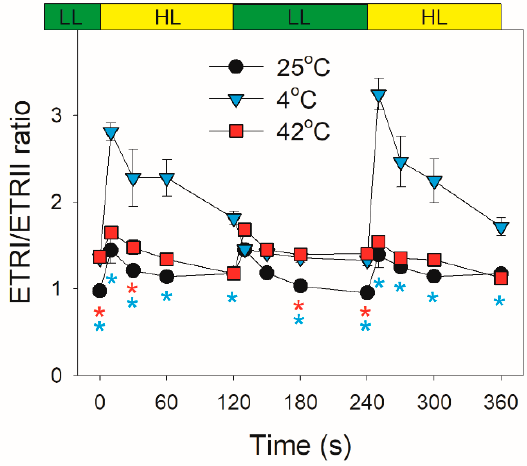
Figure 7. Changes in the ETRI/ETRII ratio after transition from 59 to 1455 µ mol photons m − 2 s − 1 at 25 °C, 4 °C, and 42 °C. Values are means ± SE ( n = 5). Red asterisks indicate significant differences between 25 °C and 42 °C, and blue asterisks indicate significant differences between 25 °C and 4 °C.